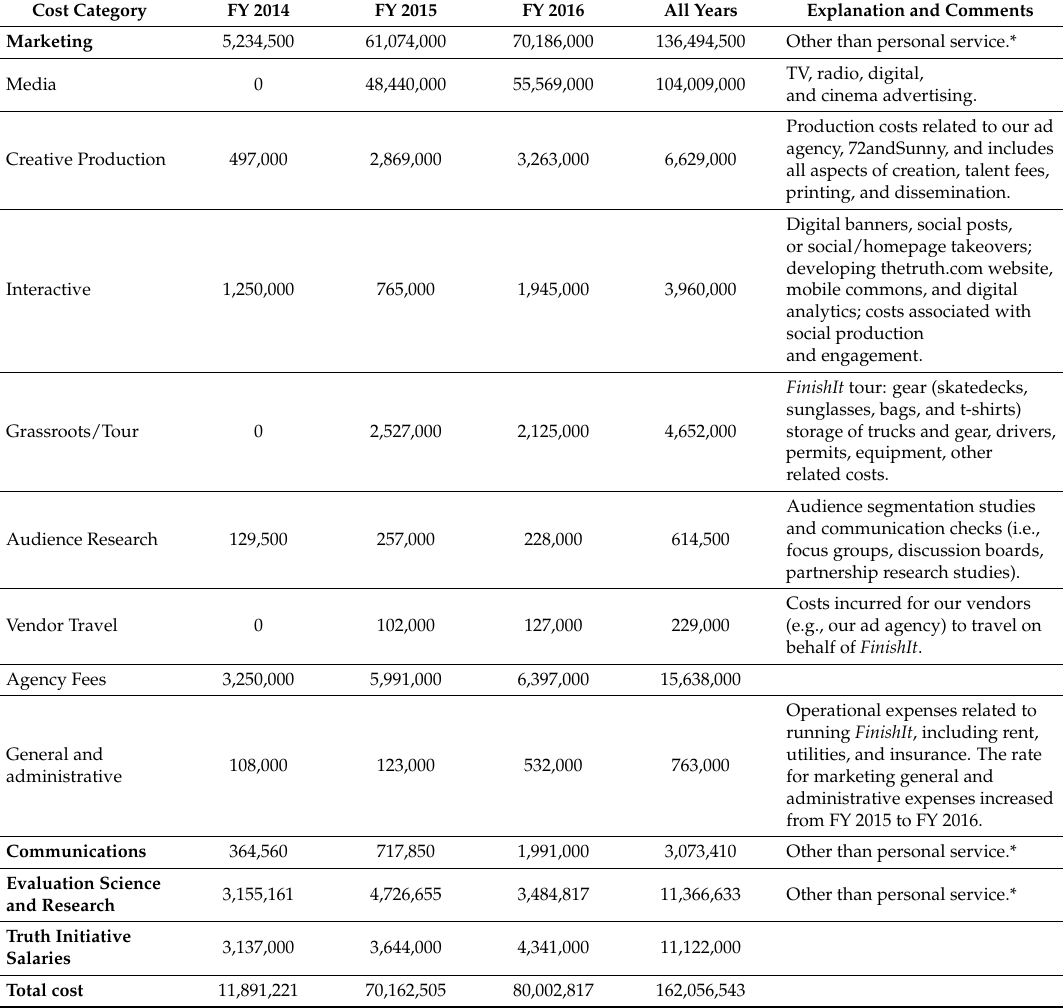
Table 2. Costs of the FinishIt campaign by fiscal year (FY) and cost category reported in US $ in year